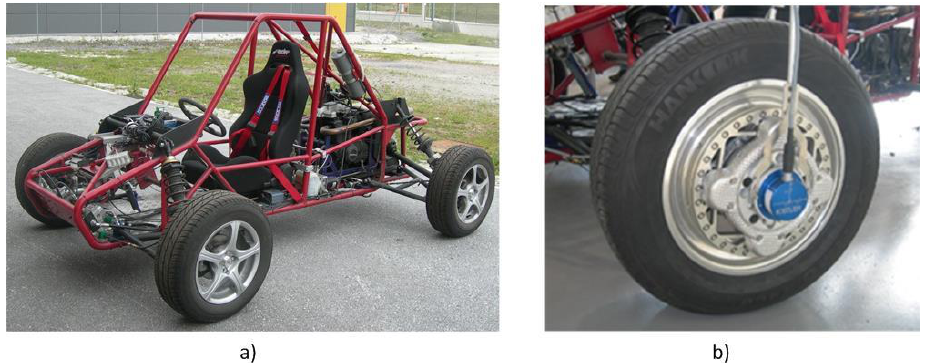
Figure 1. ( a ) IMMa sensorized vehicle. ( b ) Detail of the measuring rim.